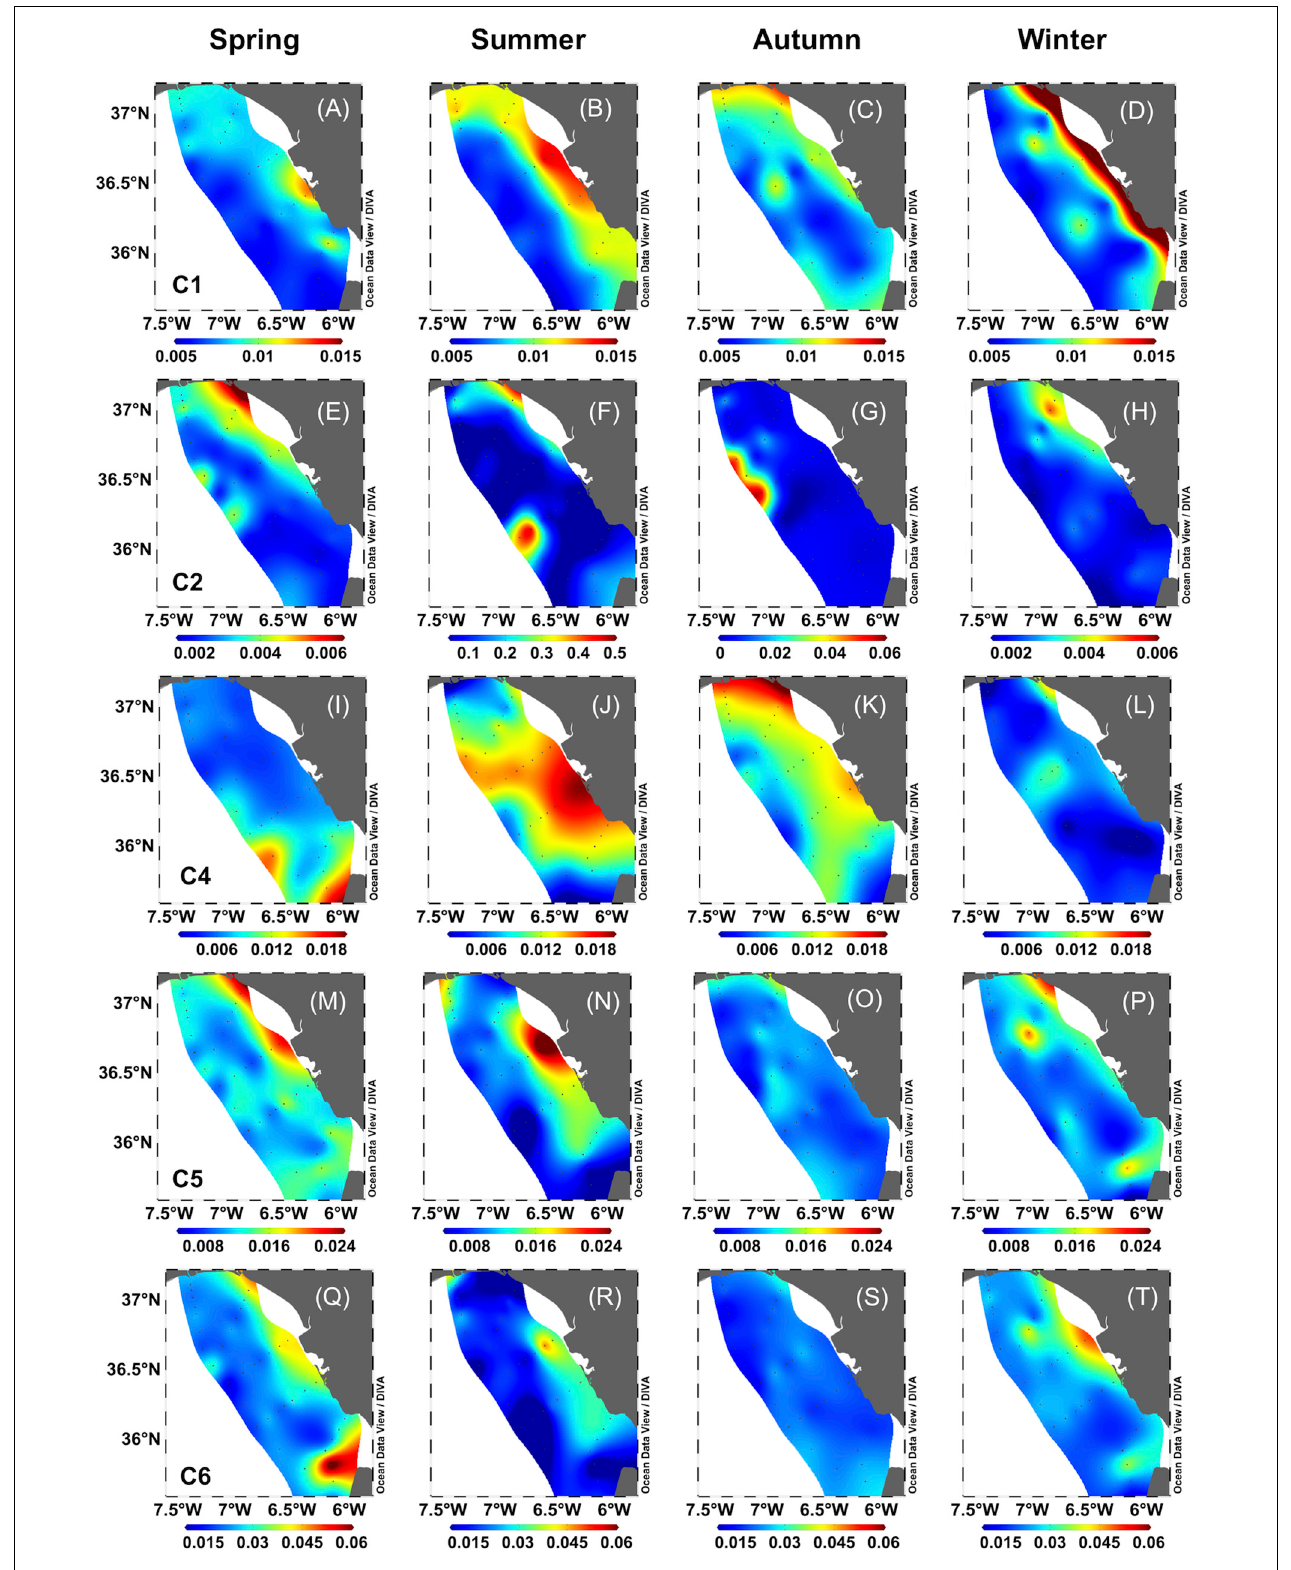
FIGURE 4 | Surface water distribution of fluorescent components for each season: (A–D) : C1, (E–H) : C2, (I–L) : C4, (M–P) : C5, (Q–T) : C6. Units are in RU. Note that C2 shows different scales in summer and autumn.